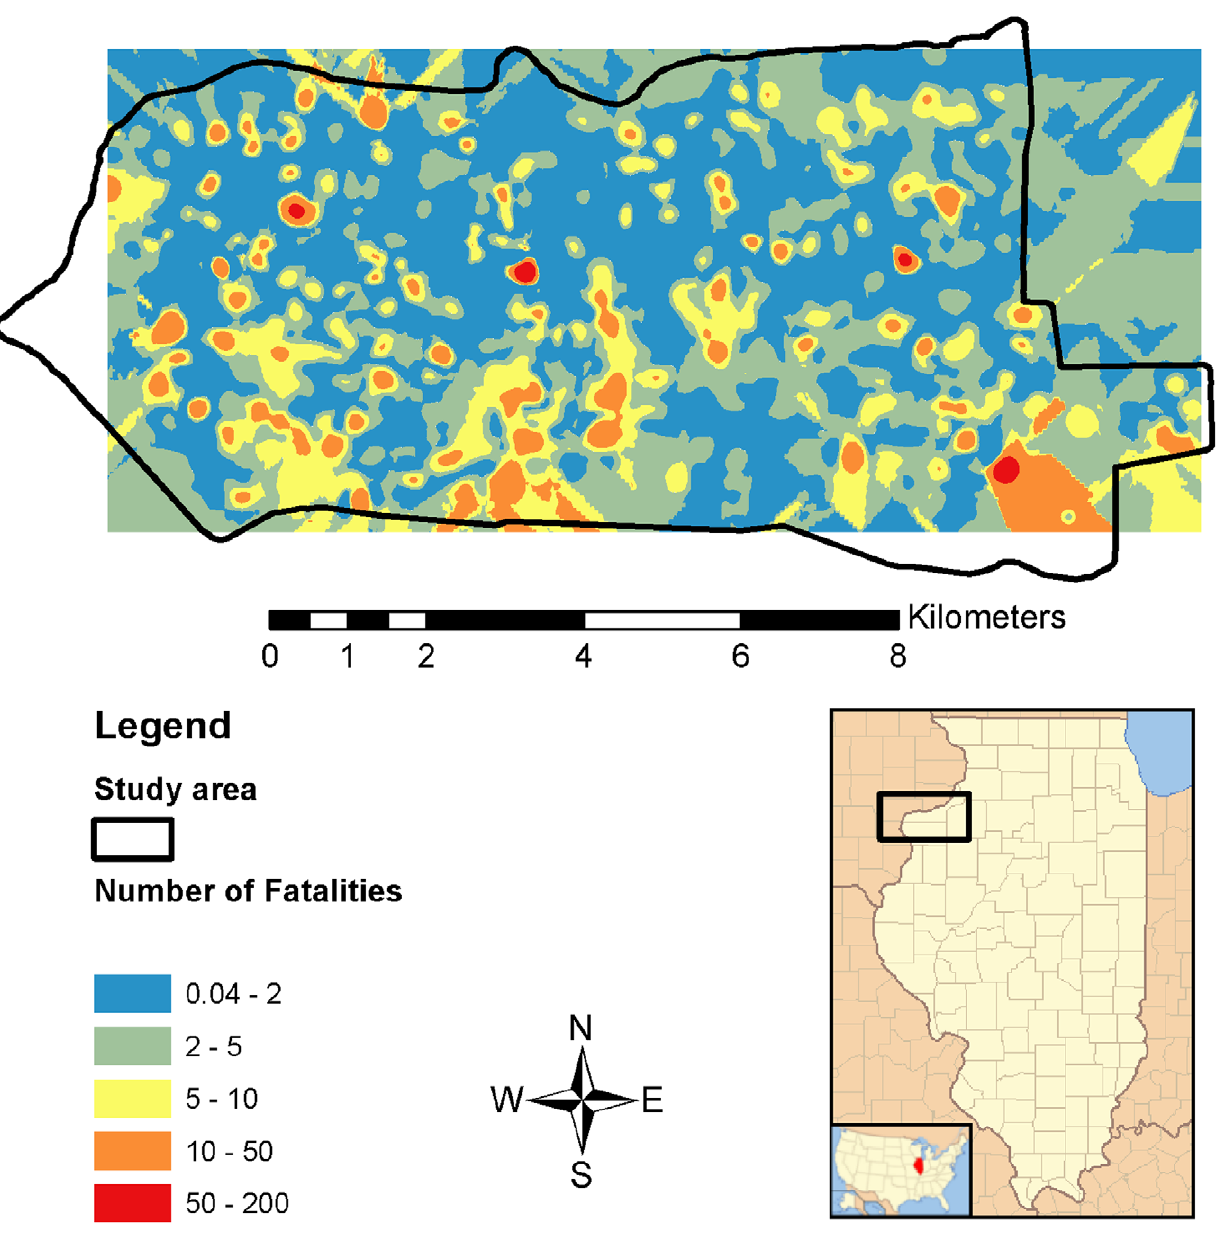
Figure 4. Predicted annual fatalities for the study area in Illinois, USA. Predicted fatalities were spatially interpolated from 1,956 model buildings using ordinary kriging.